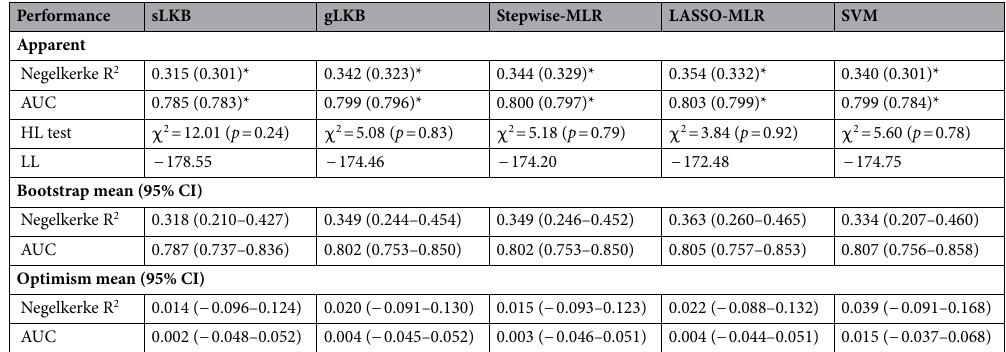
Table 3. Apparent, bootstrap performance and optimism of sLKB, gLKB, Stepwise-MLR, LASSO-MLR, and SVM models. *Apparent performance (optimism-corrected). sLKB standard Lyman–Kutcher–Burman, gLKB generalized Lyman–Kutcher–Burman, Stepwise-MLR multivariable logistic regression using stepwise feature selection, LASSO-MLR multivariable logistic regression using least absolute shrinkage and selection operator for feature selection, SVM support vector machine, AUC area under the receiver operator curve, HL Hosmer– Lemeshow, LL log likelihood, AIC Akaike information